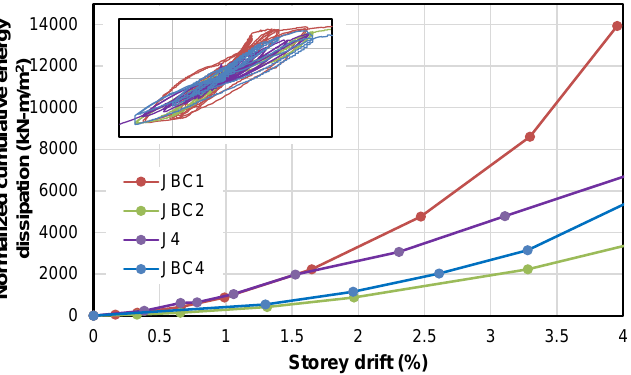
Figure 5. Cumulative energy dissipation-story drifts relationship of specimens.